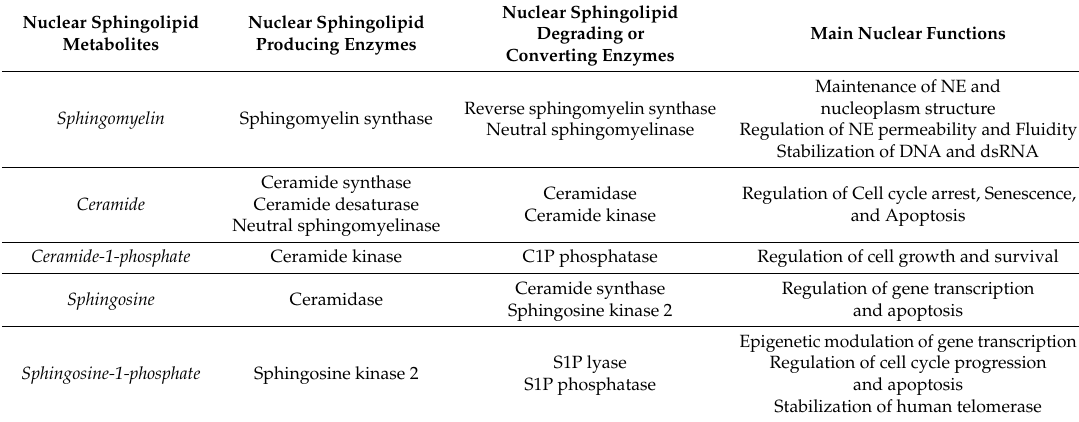
Table 1. Nuclear sphingolipid metabolites and metabolizing enzymes. This table recapitulates the various nuclear sphingolipid metabolites and enzymes detected in the nuclear compartment with a brief description of their important nuclear functions. NE: nuclear envelop, dsRNA: double stranded